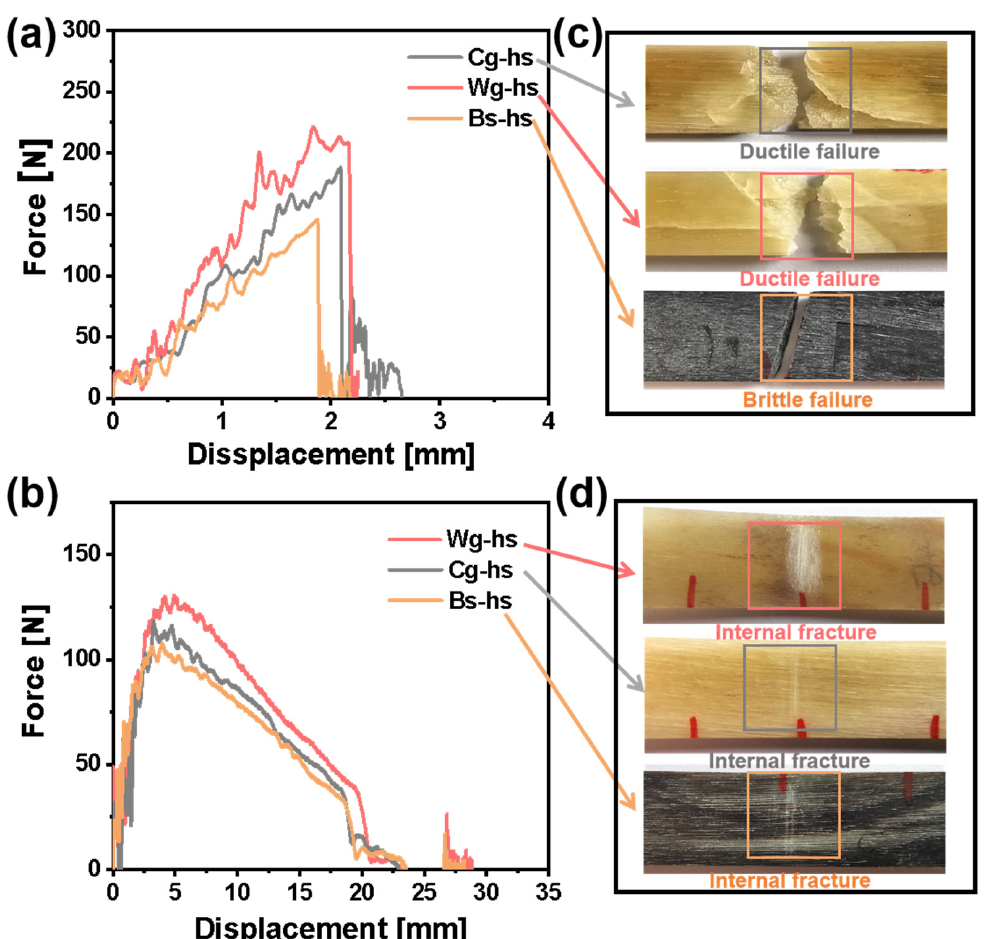
Figure 3. Impact force-displacement curves and fracture photographs of three different Caprinae horn sheaths. ( a ) Impact force-displacement curves of dried specimens; ( b ) Impact force-displacement curves of hydrated specimens; ( c ) Fracture photographs of the dried specimens; ( d ) Fracture photographs of the hydrated specimens.